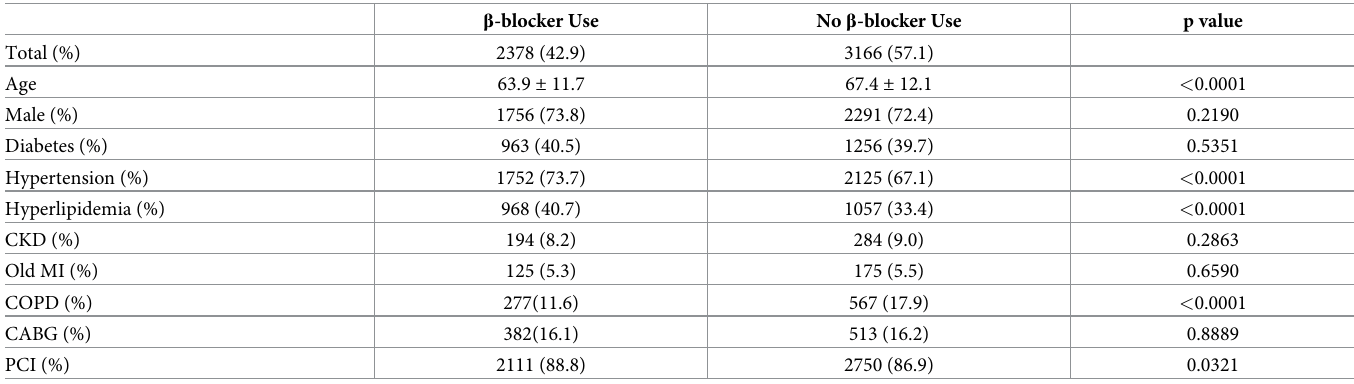
Table 3. Factors associated with β -blocker use at 12